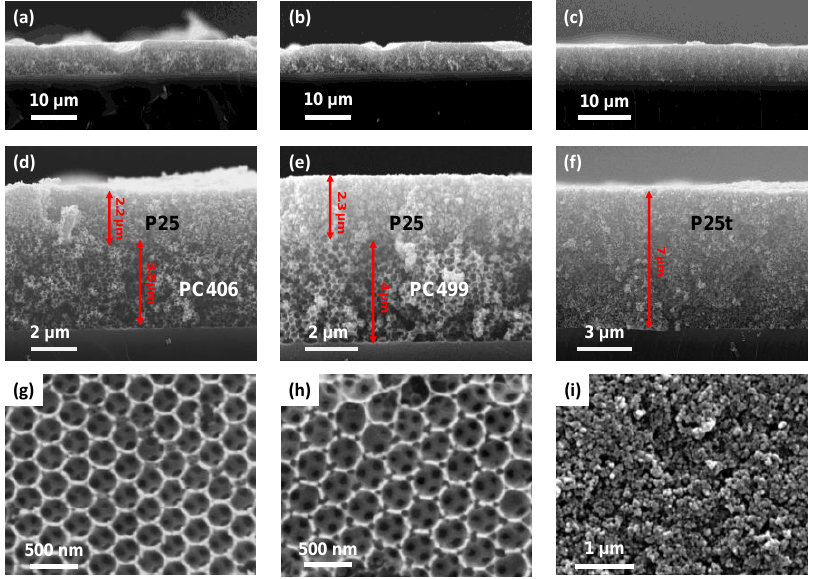
Figure 1. Cross-section SEM images of ( a , d ) CoO x -P25/PC406, ( b , e ) CoO x -P25/PC499, and ( c , f ) CoO x - P25t films at different magnifications. Top-view images of ( g ) CoO x -PC406, ( h ) CoO x -PC499, and ( i ) P25